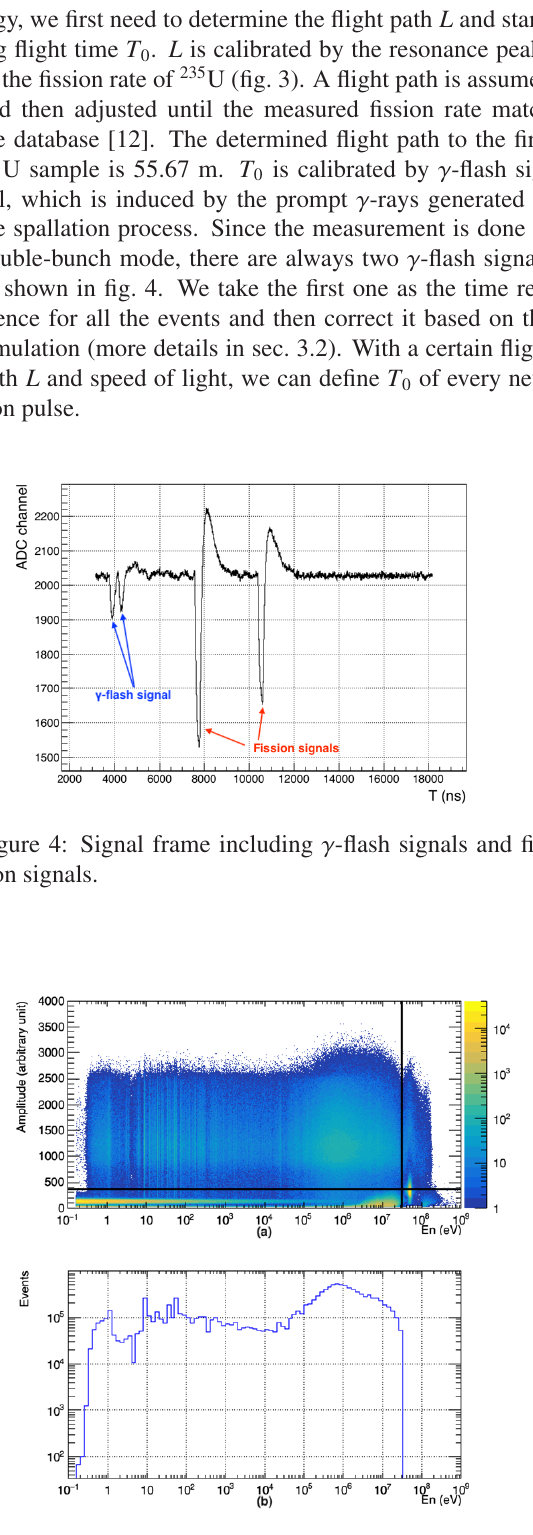
Figure 5: The 2D distribution of neutron energy versus sig- nal amplitude (a). The fission rate as a function of neutron energy (b).